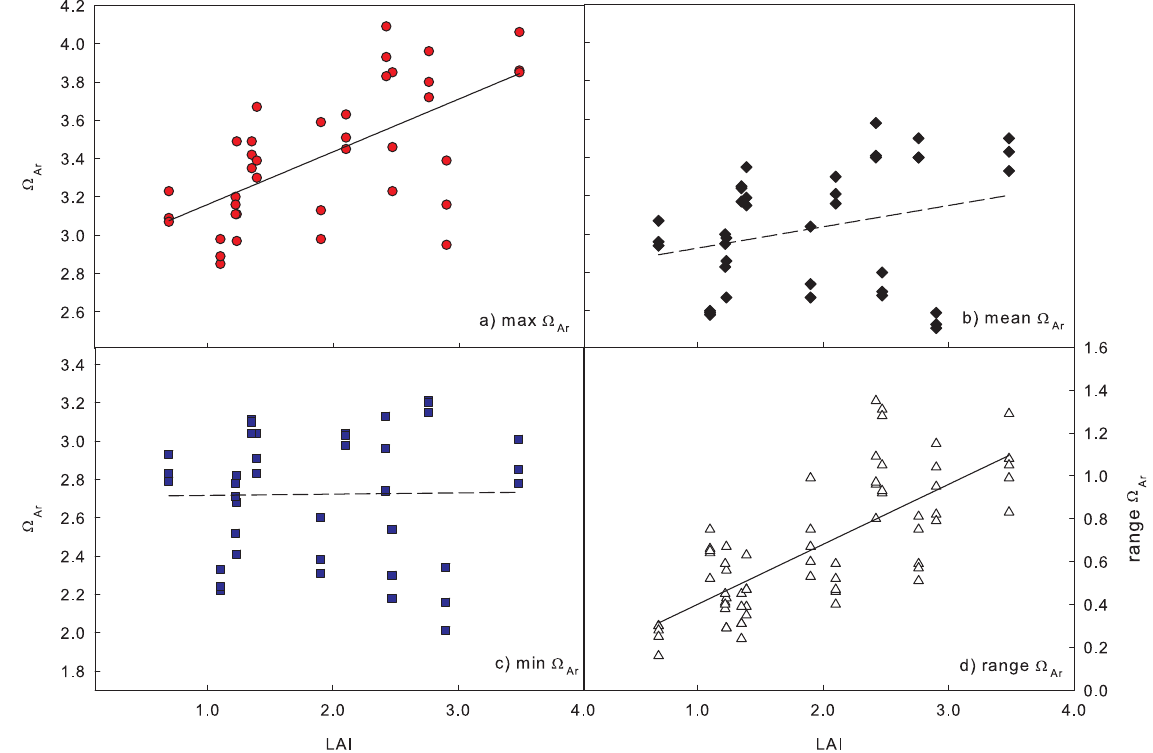
Fig. 4. The relationships between leaf area index (LAI) and (a) max, (b) mean, (c) min (cid:127) Ar and the (d) range of (cid:127) Ar . Non-significant relationships are dotted lines. The linear regression for maximum (cid:127) Ar (red circles) is 0.28 LAI + 2.87 ( r 2 = 0 . 40). Mean (cid:127) Ar are black diamonds, Minimum (cid:127) Ar are blue squares while the range of (cid:127) Ar (right y axis) are white triangles with linear regression 0.28 LAI + 0.12 ( r 2 = 0 . 56). Table 4. Results from Generalized Linear Models (glm package in R) with gaussian distribution testing the effect of hydrodynamics on the (cid:127) Ar . TKE U velocity Re stress t p t p t p September Mean − 0.303 0.78